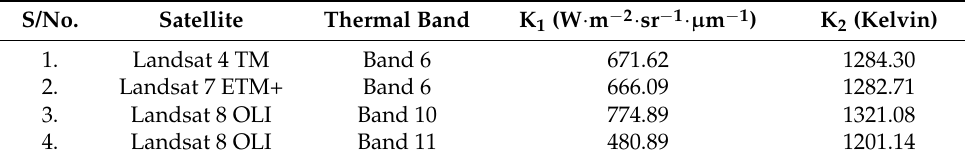
Table 4. Landsat Thermal Band Calibration